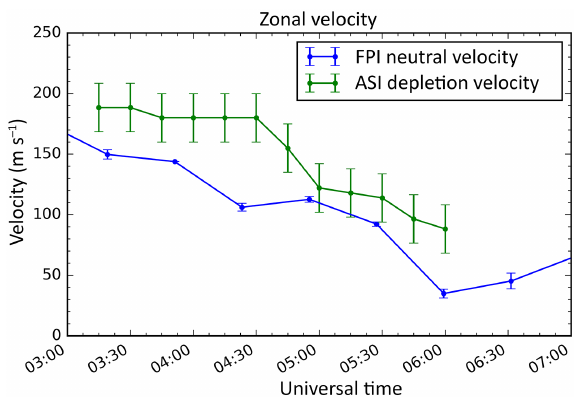
Figure 11. Zonal neutral winds (blue) and zonal plasma drifts (green) on 3 April 2014 at Jicamarca. Zonal wind speeds are deter- mined by an FPI and plasma drifts are determined from depletion